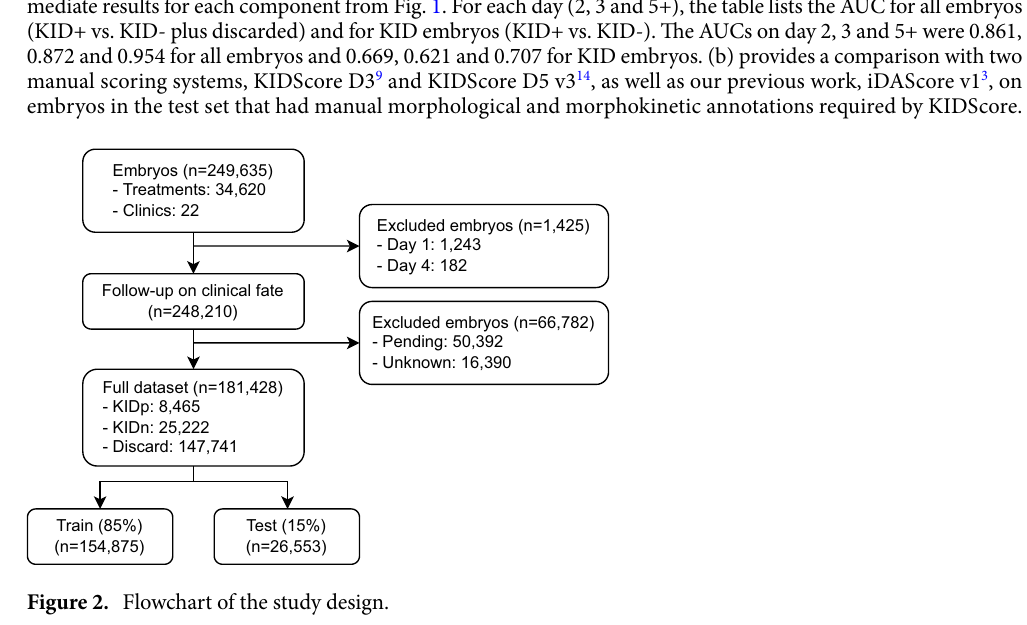
Figure 2. Flowchart of the study